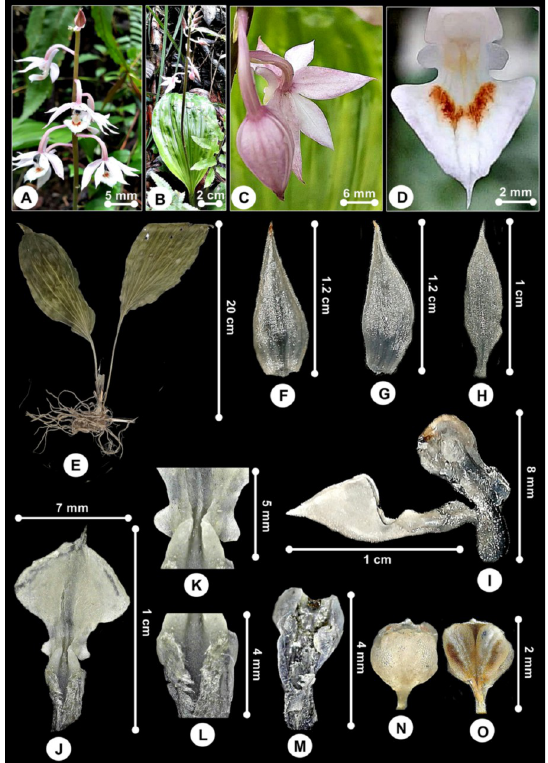
Fig 4. Calanthe chrysoglossoides . A. Inflorescence. B. Plant in the natural habitat. C. Dorsal view of the flower. D. Labellum with a central orange mark. E. Plant (dried specimen). F. Dorsal sepal. G. Lateral sepal. H. Petal. I. Lateral view of the labellum and Gymnostemium showing canaliculated claw. J. Labellum (flattened). K. Close-up of the labellum side lobes. L. Pubescent claw. M. Gymnostemium including foot. N. Anther-cap. O. Pollinia. Note: F-O are preserved